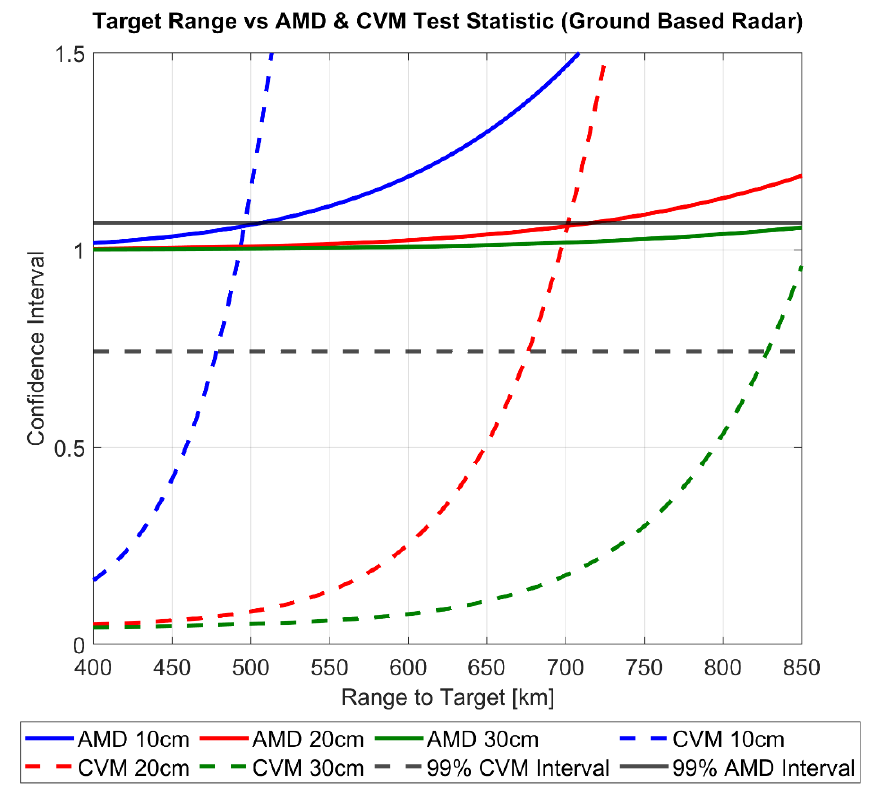
Figure 7. Covariance realism of theoretical uncertainty volume as a function of range to target for Ground-Based Radar.